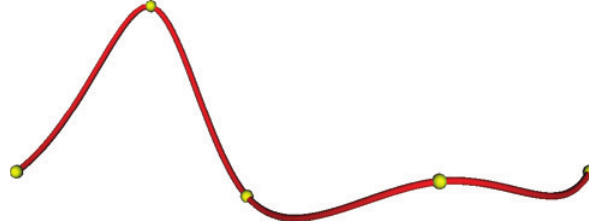
Figure 3: Periodic cubic spline.